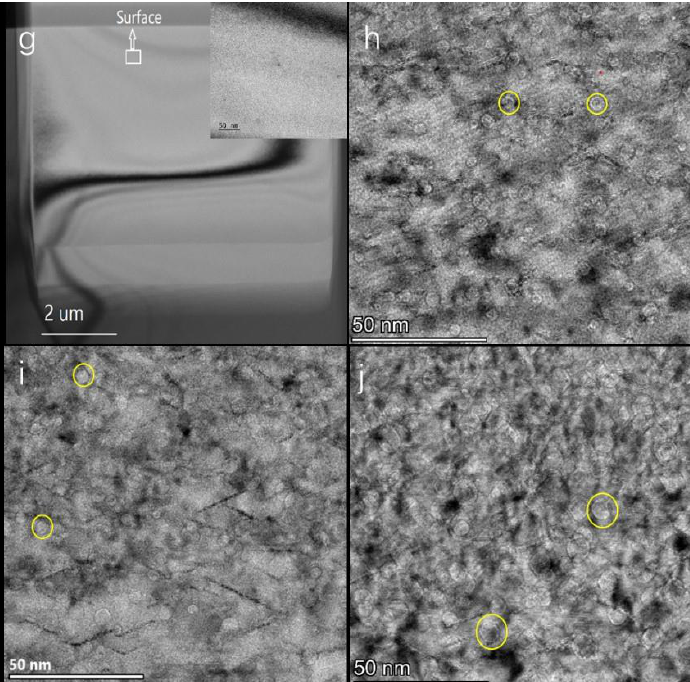
Figure 4. TEM images of different helium ion (100 Kev) doses at 180 ◦ , ( g ) 1 × 10 16 ions/cm 2 , the enlarged area (inset) indicates that no helium bubble structure was observed, ( h ) 2.5 × 10 16 ions/cm 2 ,